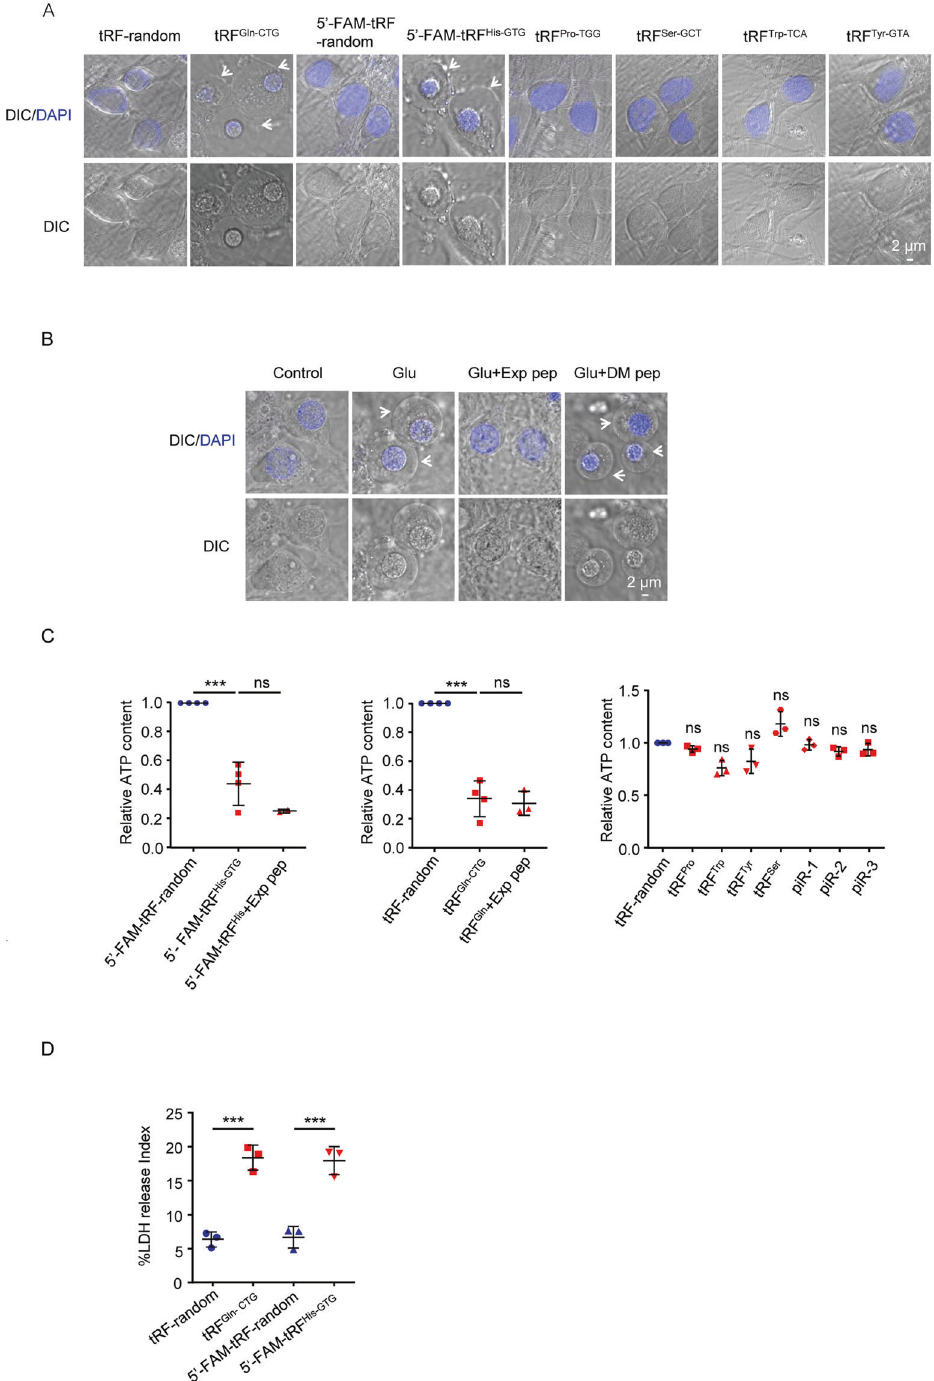
Fig. 2 The cytotoxic effect of transfected tRFs and piRNAs in neuronal culture. Synthetic tRFs and piRNAs were transfected in primary neuron culture. For controls, a scrambled sequence of tRF was synthesized (tRF-random), or the FAM tag was added at the 5 ′ of the control (5 ′ - FAM-tRF-random). Then, their toxicity was assessed by the ATP content and LDH release assays. A After 4 h of tRFs transfection, typical morphological change of neurons under confocal. White arrows pointed to the swollen neurons. Trial n = 3. B The swollen neuron morphology was also observed after glutamate treatment for 3 h. Trial n = 3. C After 3 h transfection, the total cellular ATP level was determined. Three synthesized piRNAs were tested, including piR-rno-318194 (piR-1), piR-rno-888357 (piR-2), and piR-rno-2898628 (piR-3). Because of variations in each culture condition (different embryo age and cell number), the ATP levels of the controls were set as 1, and relative ATP level changes of the other conditions (tRFs and piRNAs) were plotted. Trial n = 2 − 4. One-way ANONA analysis was performed for comparison of more than three groups in all of the following fi gures, with post-hoc test Tukey for comparison between two groups. * P < 0.05, ** P < 0.01, and *** P < 0.001. D For the LDH assay to quantify cell death, the cell medium and neurons were collected separately at 12 h after transfection. The cell death index = LDH medium / (LDH medium + LDH cell ) × 100. The conditions of treatment were listed on the dot graph. Trial n =